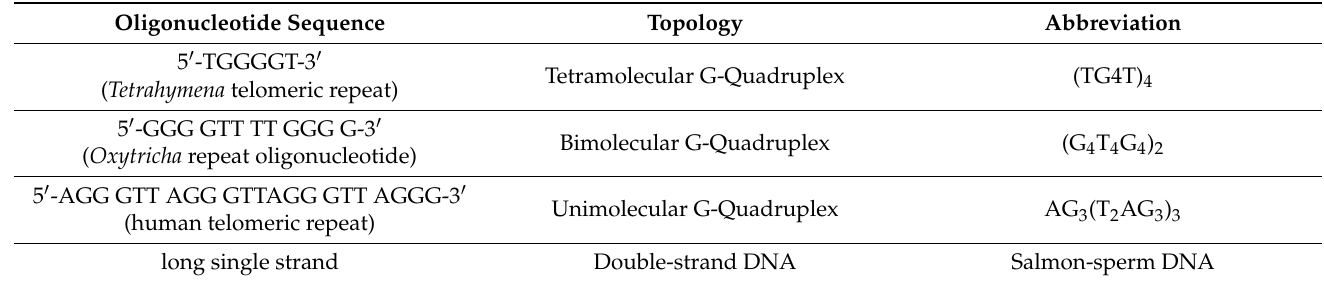
Table 2. Sequence and topology of studied oligonucleotides. Oligonucleotide Sequence